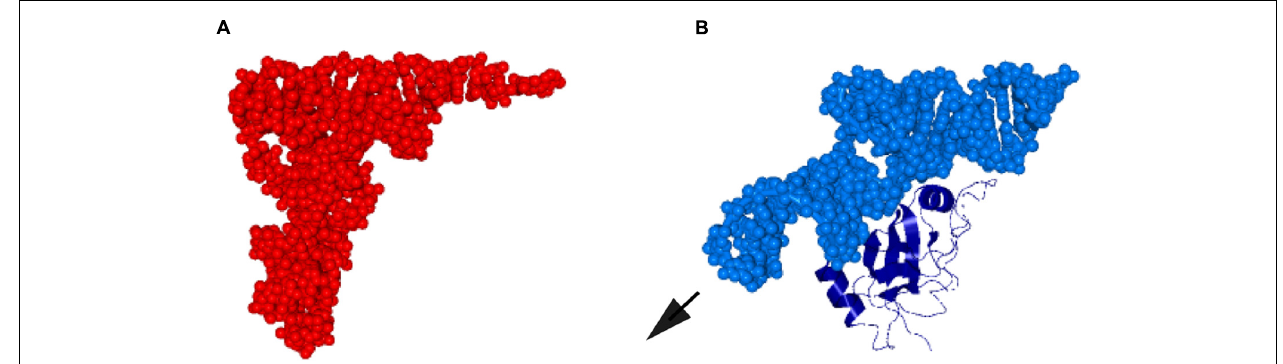
FIGURE 2 | Molecular mimicry of tRNA by the globular domain of SmpB and TLD. (A) Saccharomyces cerevisiae tRNA Phe represented by space-filling model (PDB ID: 1EHZ). (B) A complex of TLD (the 5 (cid:2) 25 residues and the 3 (cid:2) 34 residues connected by a UUCG loop) of T. thermophilus tmRNA represented by space-filling model and the globular